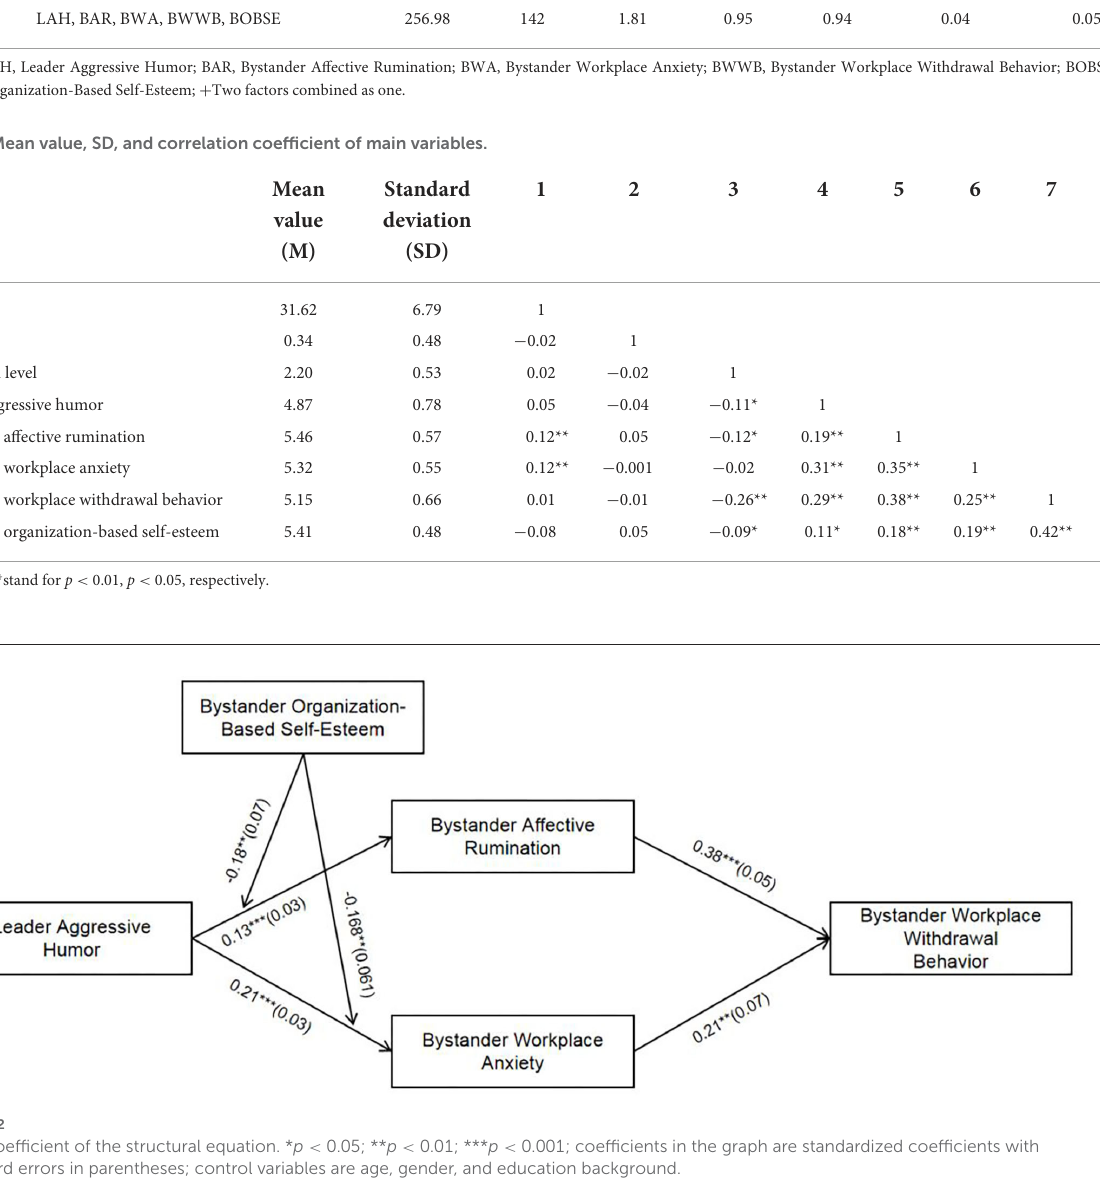
Leader aggressive humor is significantly positively correlated with bystander affective rumination ( β = 0.13, p < 0.001) and bystander workplace anxiety ( β = 0.21, p < 0.001), therefore, H1 and H2 are